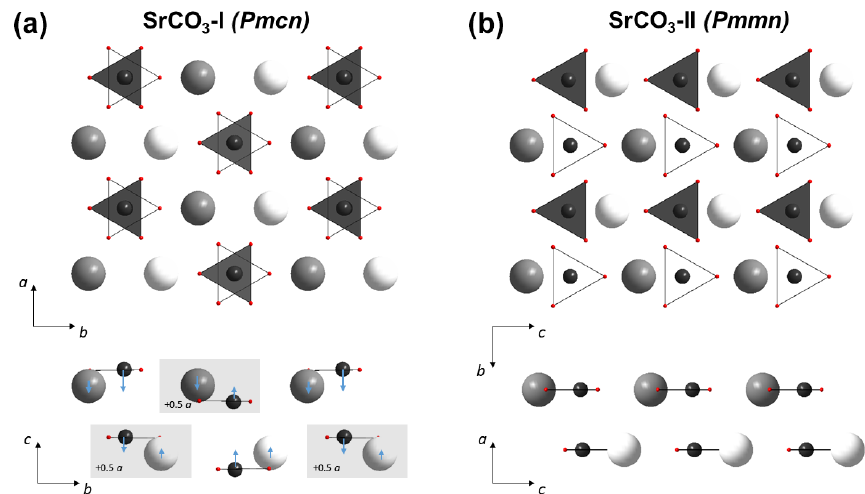
Figure 4. Crystal structures of SrCO 3 -I (a) and SrCO 3 -II (b) . Axis a , b , and c in SrCO 3 -I ( Pmcn ) correspond to b , c and a axis in SrCO 3 -II ( Pmmn ). Small-sized red spheres correspond to oxygen atoms, black spheres are carbon, CO 2 − dark grey triangles, with different positions along the c axis in SrCO 3 -I and along the a axis in SrCO 3 -II. White and dark grey spheres are Sr 2 + . During the phase transition from aragonite to post-aragonite half of Sr 2 + and CO 2 − 0.5[100] and then the ions line up in the (001) plane (the directions of displacements are shown by small blue